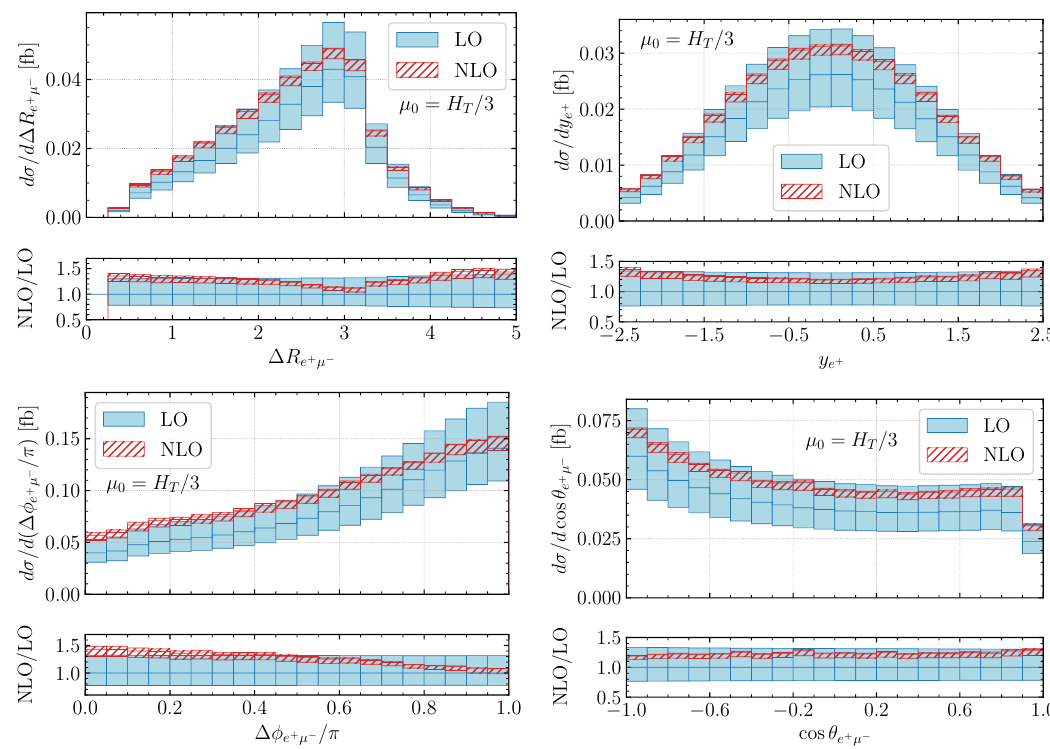
Figure 8 . Differential cross-section distributions for pp → e + ν e µ − ¯ ν µ b ¯ b τ + τ − + X at the LHC with √ s = 13 TeV as a function of ∆ R , y , cos θ and ∆ φ . The blue curve corresponds to e + e + µ − e + µ − e + µ − the LO and the red curve to the NLO result. Also shown are the corresponding uncertainty bands resulting from scale variations. The lower panels display the differential K -factor together with the uncertainty band and the relative scale uncertainties of the LO cross section. The scale choice is µ R = µ F = µ 0 = H T / 3 . The cross sections are evaluated with the NNPDF3.1 PDF sets.